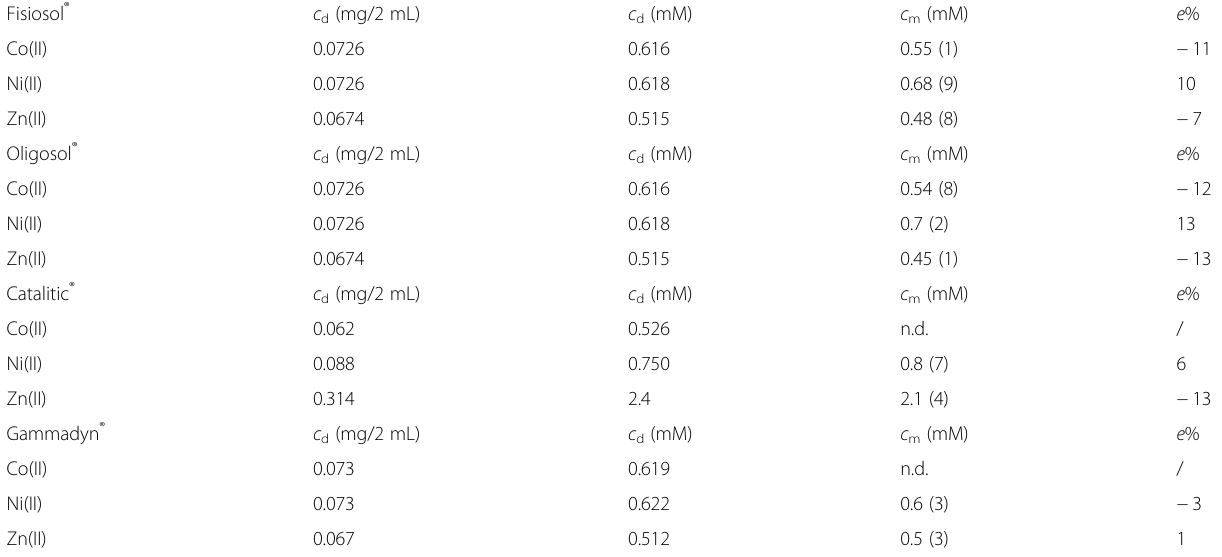
Table 5 Prediction of Co(II), Ni(II), and Zn(II) values in four commercial oligomineral supplements by the PLS model, from UV-vis spectra measurements, using